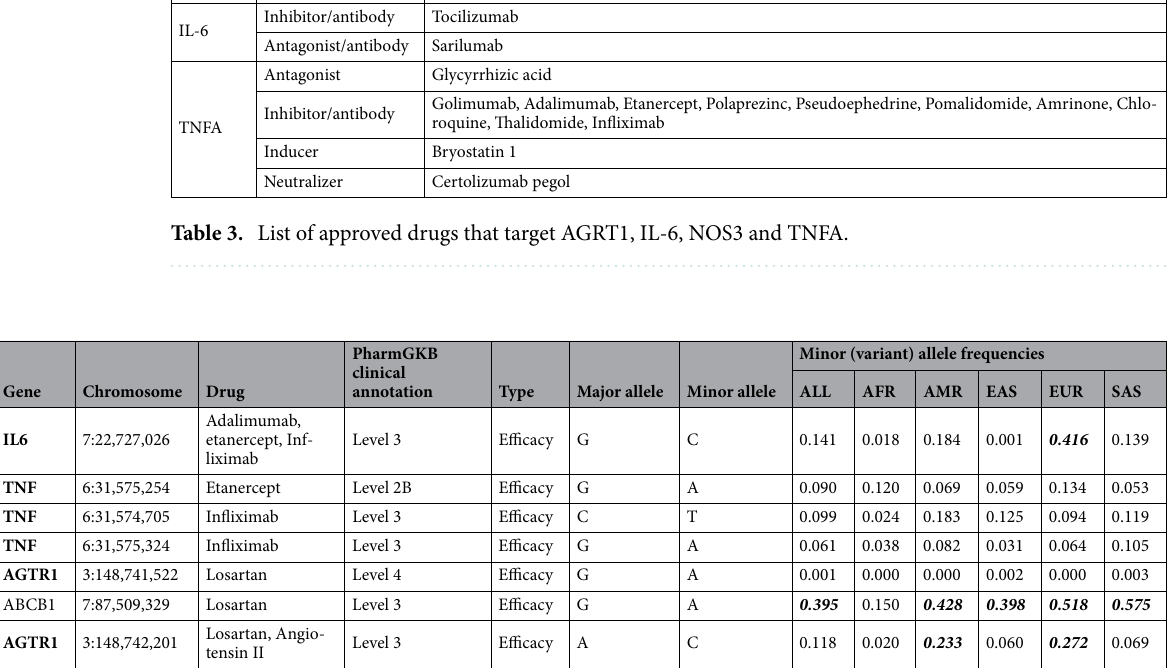
Table 4. Variant alleles of AGTR1, IL6, NOS3 and TNFA that are known to modulate responses to approved drugs. SNPs and genes that are associated with diabetes and its complications are written in bold letters. MAFs ≥ 0.2 are shown in bold italic